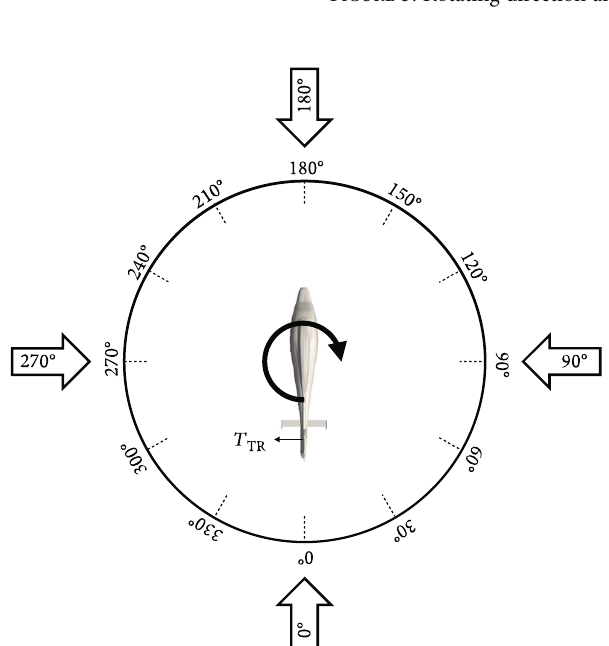
Figure 3: Rotating direction and method employed for each rotor.